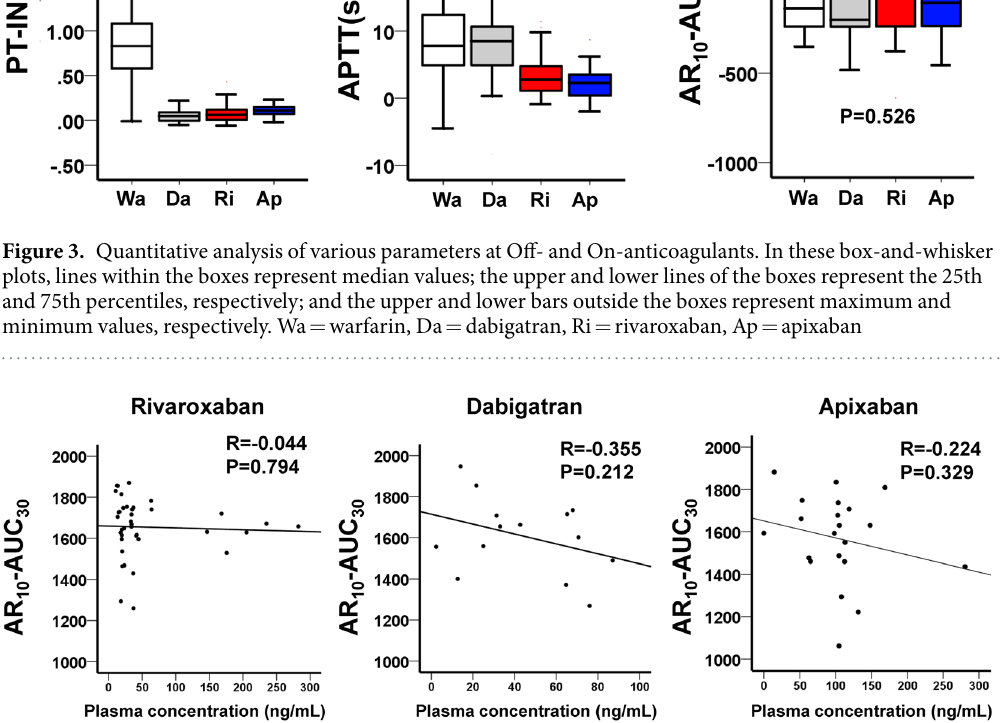
Figure 4. Scatter plots of AR 10 -AUC 30 levels and plasma concentrations of DOACs. Relationship between AR 10 - AUC 30 levels measured by T-TAS and plasma concentrations of rivaroxaban, dabigatran and apixaban measured by the respective coagulation assays at